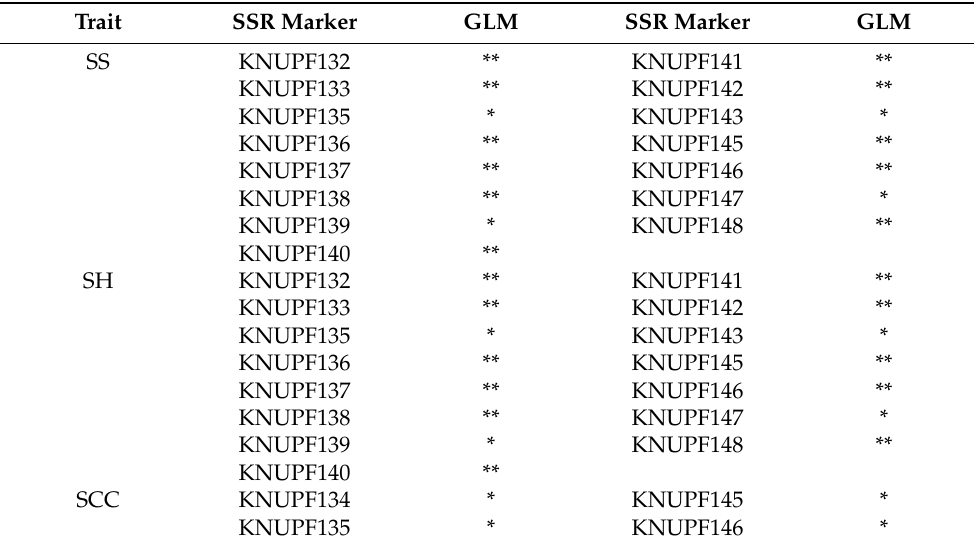
Table 3. Information on SMTA markers using GLM method for 90 Perilla accessions.